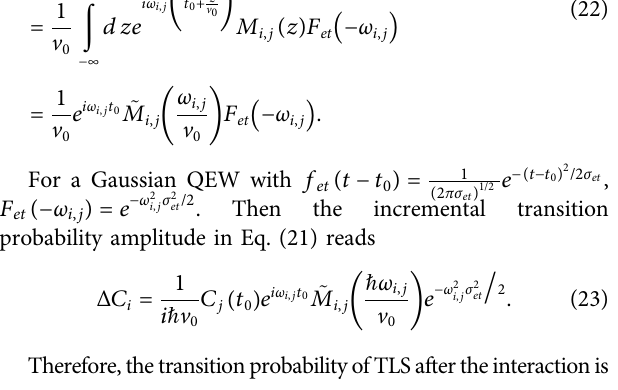
interaction strength f ( t − t 0 ) can be recast into a convolution